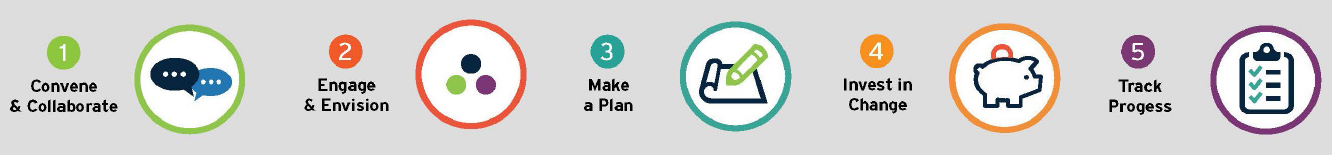
(ChangeLab Solutions,